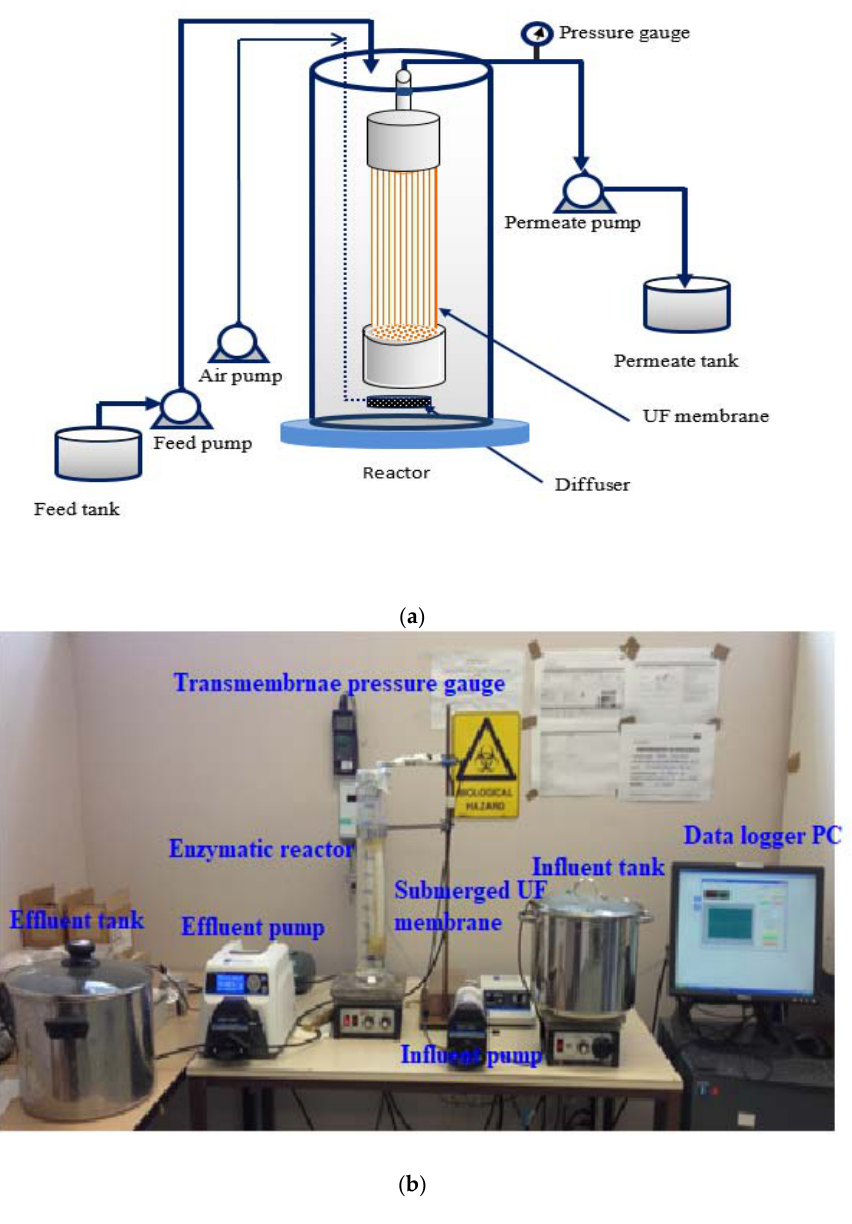
Figure 2. A schematic diagram ( a ) and a photography of laboratory scale enzymatic membrane reactor ( b ).